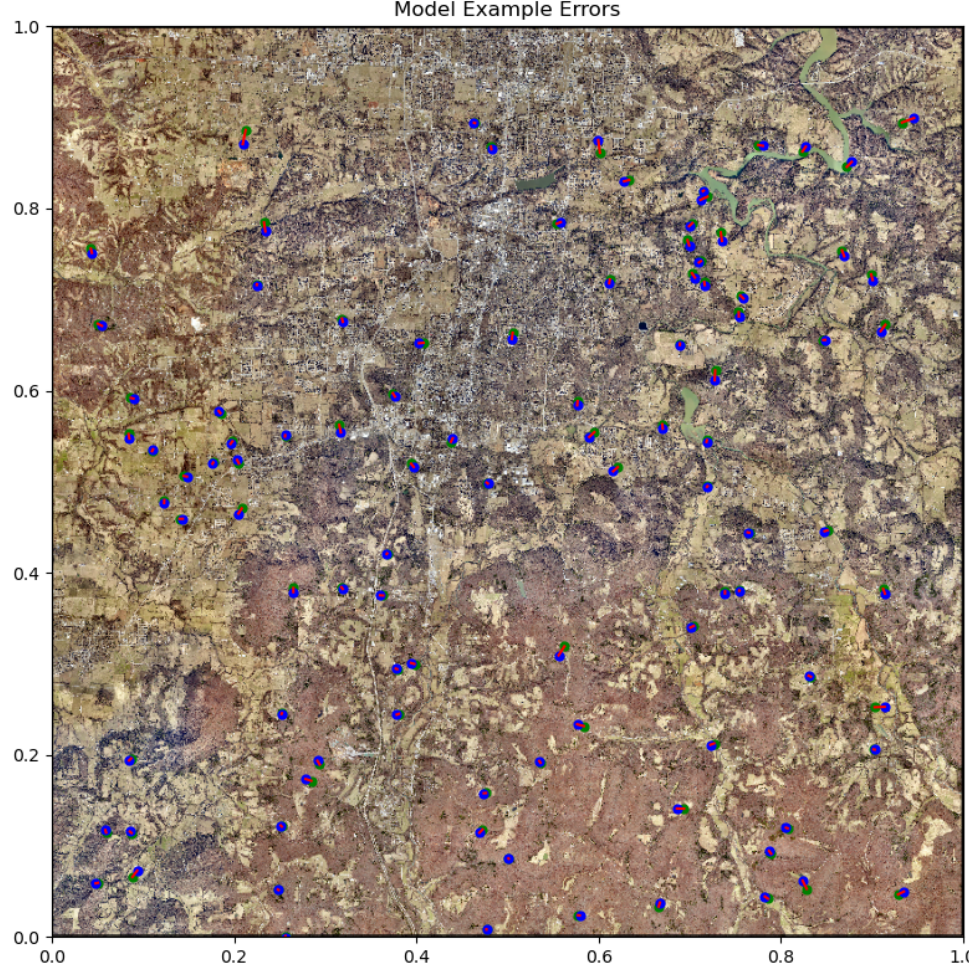
Figure 3. Figure demonstrating 100 sample errors of one of the runs (WaCo2020). Green is the true location, blue is the prediction, where predictions are connected to their true location by a red line. The background is of the holdout data set over the